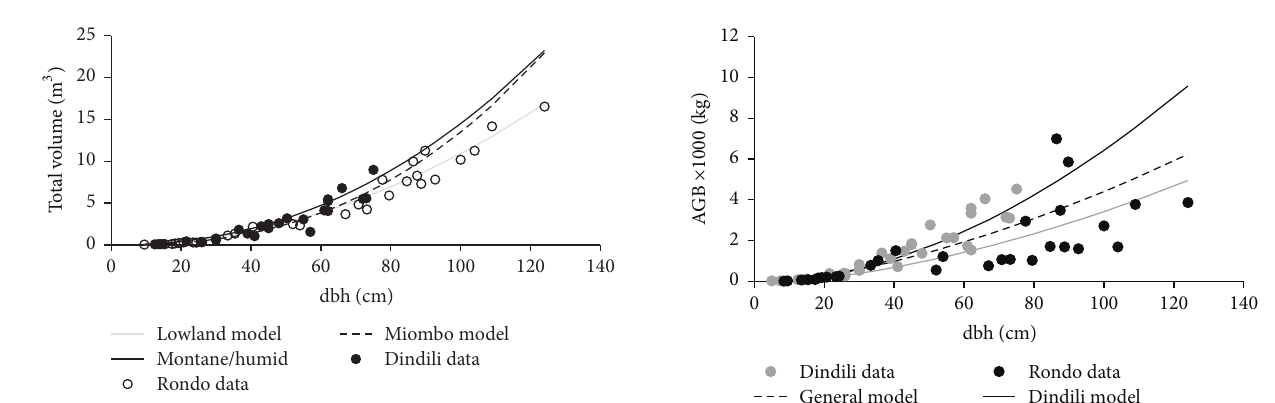
Figure 3: Comparison of lowland forest, miombo woodlands, and Montane/humid volume models. Lowland volume estimates computed by model (8). Total tree height was estimated using the developed ht-dbh models.